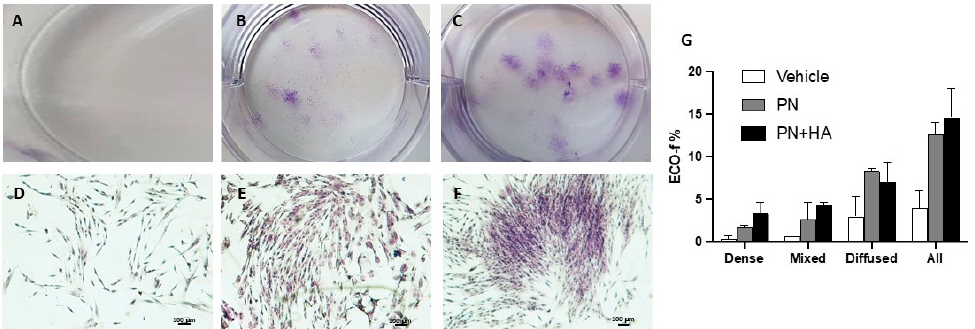
Figure 2. ( A – C ) Clonogenic efficiency assay, representative wells from the control ( A ), PN ( B ) and PN + HA ( C ) groups. Stained colonies appeared as diffused ( D ), mixed ( E ) or dense ( F ), according to how densely packed cells appeared. These microphotographs were taken at 4 × magnification (Bar = 100 µ m). ( G ) Clonogenic efficiency for control, PN and PN + HA groups, counting all colonies or dense, mixed and diffused colonies, separately, expressed as mean ± SD.